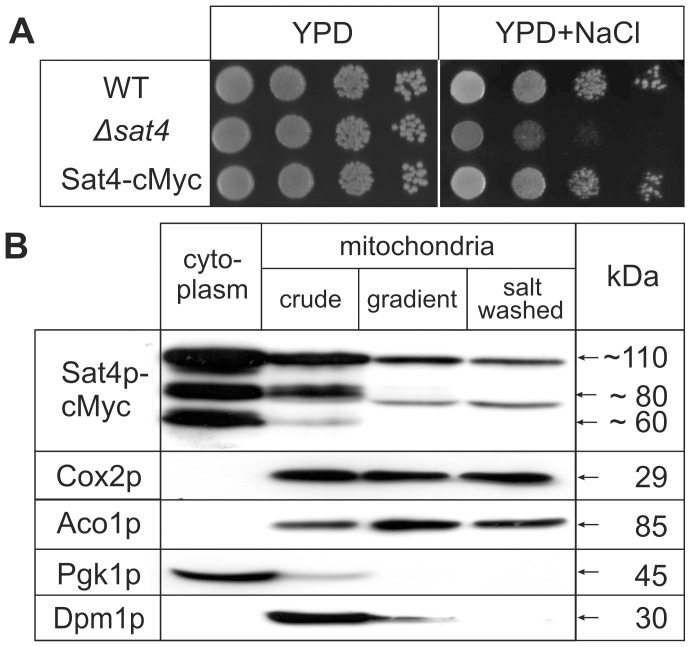
Intracellular localization of Sat4p.(A) Functional complementation of the cMyc-tagged Sat4p: Cells of wild type (WT), deletion strain Δsat4 and strain Sat4-cMyc were dropped in a dilution series (104 to 101 cells) on YPD with or without 1 M NaCl. Growth was documented after incubation for two (YPD) or four days (+ NaCl) at 30°C. (B) Mitochondria of the strain expressing Sat4p-cMyc were enzymatically prepared. 50 µg of cytoplasmic (lane 1) or mitochondrial proteins before (lane 2) and after (lane 3) purification by two successive sucrose gradients followed by a wash step with 1 M NaCl (lane 4) were subjected to 10% SDS-PAGE. Western blot analysis was performed with the indicated antibodies.